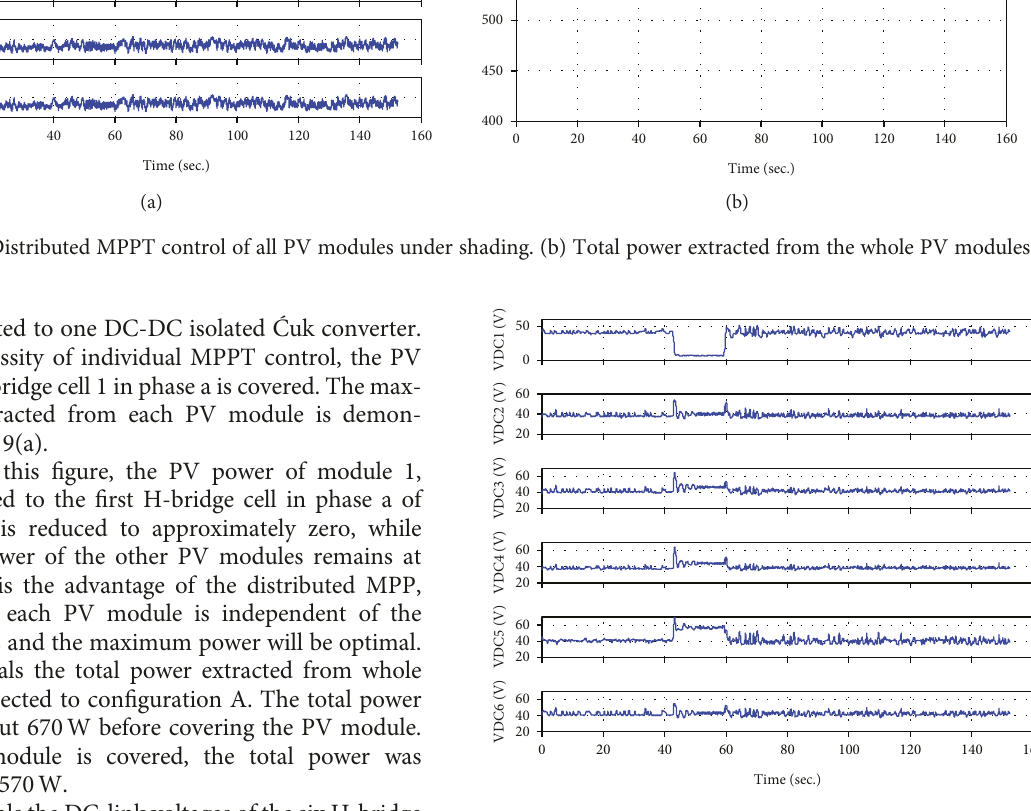
Figure 20: DC-link voltages with distributed MPPT